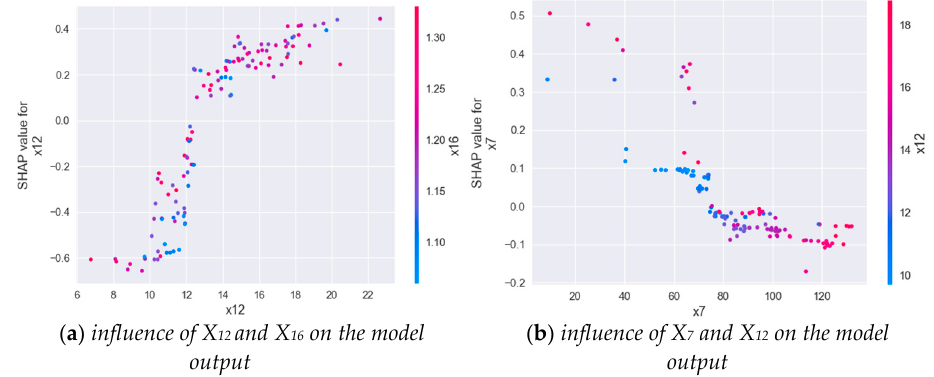
Figure 11. SHAP feature dependency graph examples of important indicators.